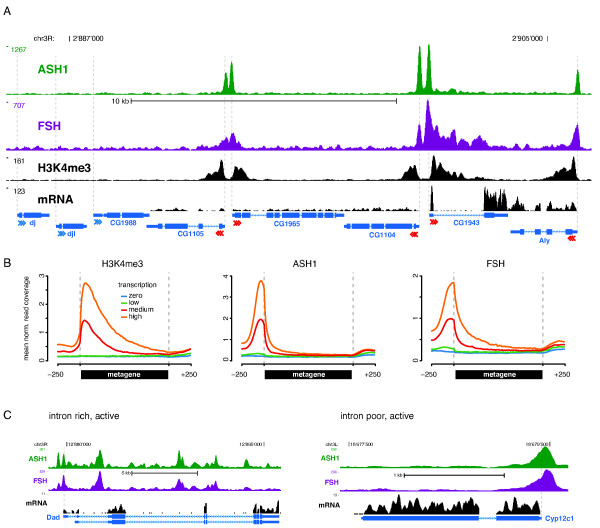
ASH1, FSH co-localization correlates with gene expression. (A) Modified UCSC genome browser view of a representative genomic region containing silent (blue arrowheads) and active genes (red arrowheads). ASH1 and FSH tracks show data as described before; H3K4me3 track displays read coverage profile for H3K4me3 ChIP-seq experiment; mRNA track contains coverage profile obtained by short-read sequencing of mRNA (RNA-seq). FlyBase gene models are depicted below track area; arrowheads indicate direction of transcription; vertical dashed lines mark TSS positions. (B) Graphs show normalized ChIP-seq read density profiles across genes grouped according to their expression level (zero, low, medium, and high). (C) Comparison of ASH1, FSH ChIP-seq signals across intron-rich and intron-poor, active genes. Tracks display data as described before. Intron-rich, active genes show strong ASH1, FSH signals inside gene bodies in contrast to their intron-poor counterparts. Both gene classes share promoter proximal signals.